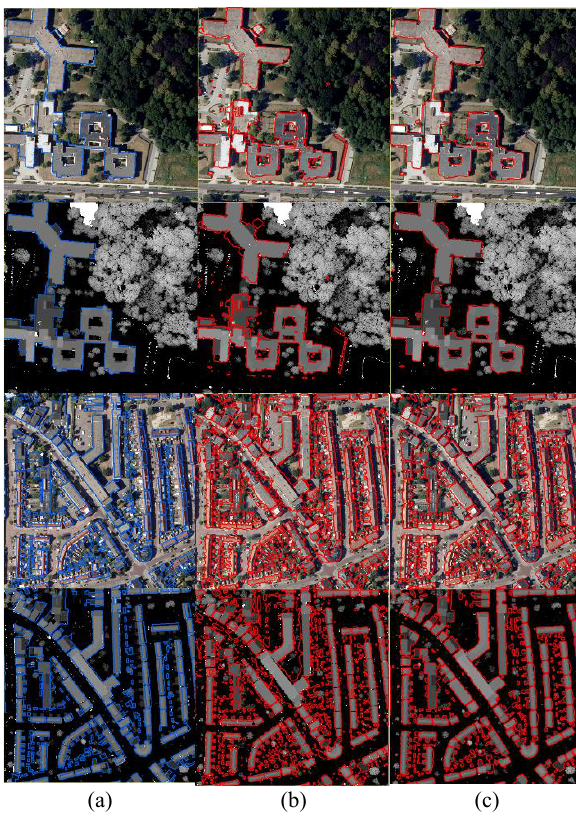
Figure 6. Results on the urban area test dataset. The background is the aerial image and the corresponding nDSM. The predicted polygons produced with 1 for the tolerance parameter of the polygonization method. From left to right: (a) Reference building footprints, (b) Predicted polygons on aerial images (RGB), (c) Predicted polygons on composite images (RGB + nDSM)